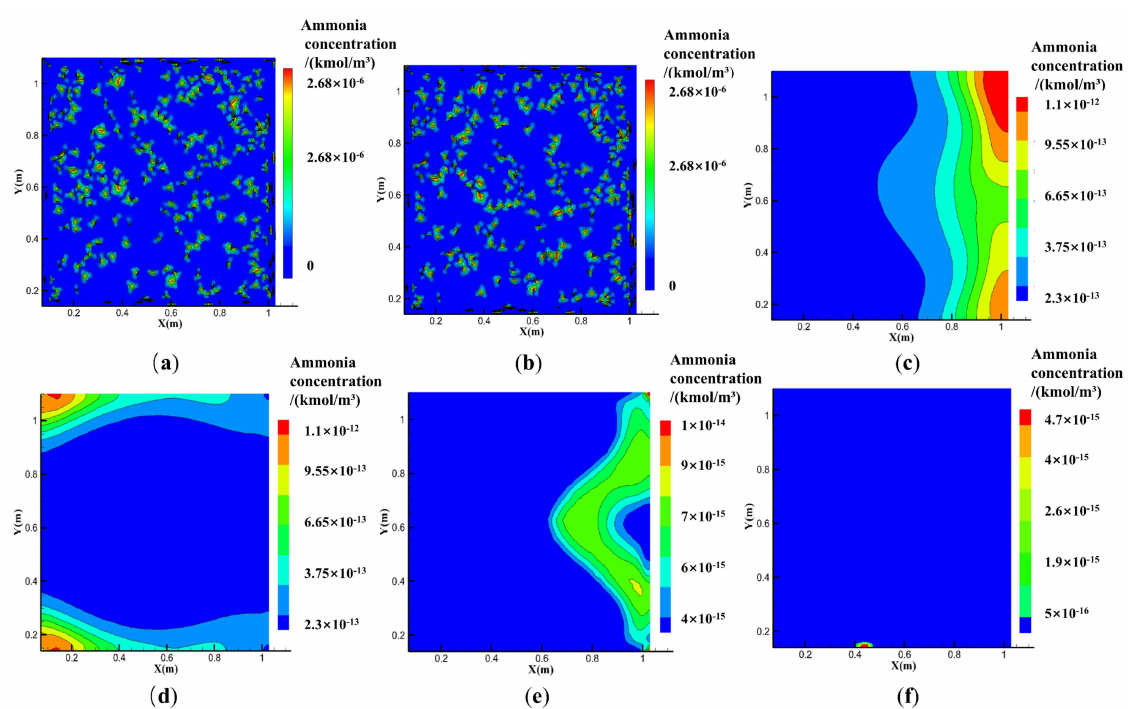
Figure 15. Ammonia concentration distributions for different ACH (unit: h − 1 ) values (Z = 0.9 m EFP-F 1 ). ( a ): ACH = 0;